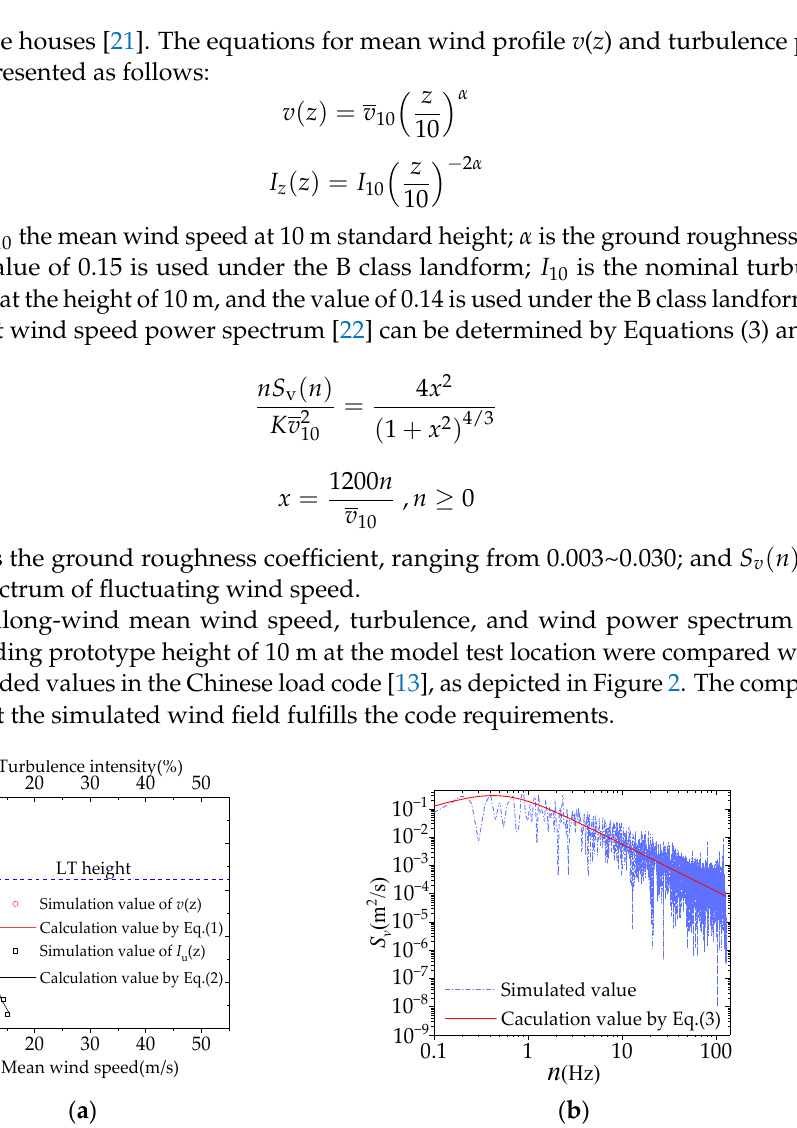
Figure 2. Simulated wind flow in the wind tunnel: ( a ) Mean wind speed and turbulence intensity profiles; ( b ) Wind power spectrum profiles.